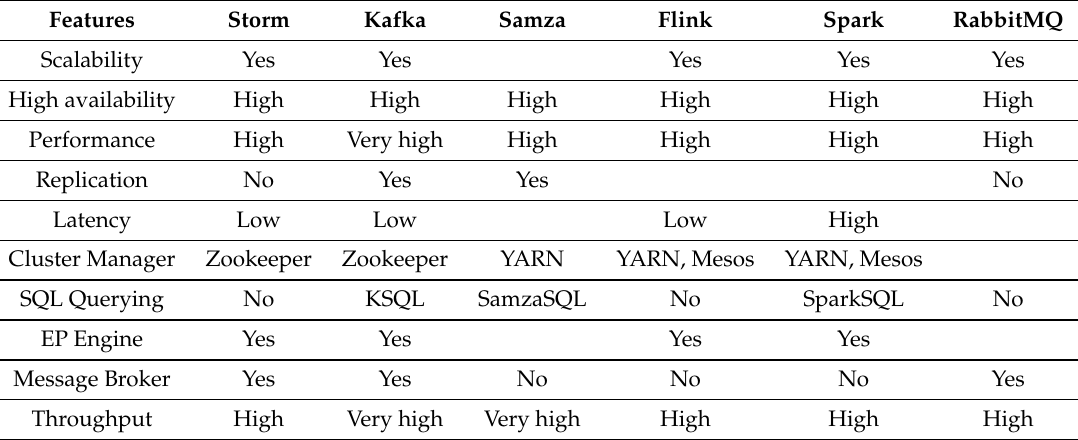
Table 1. Features of existing stream processing engines, platforms and message